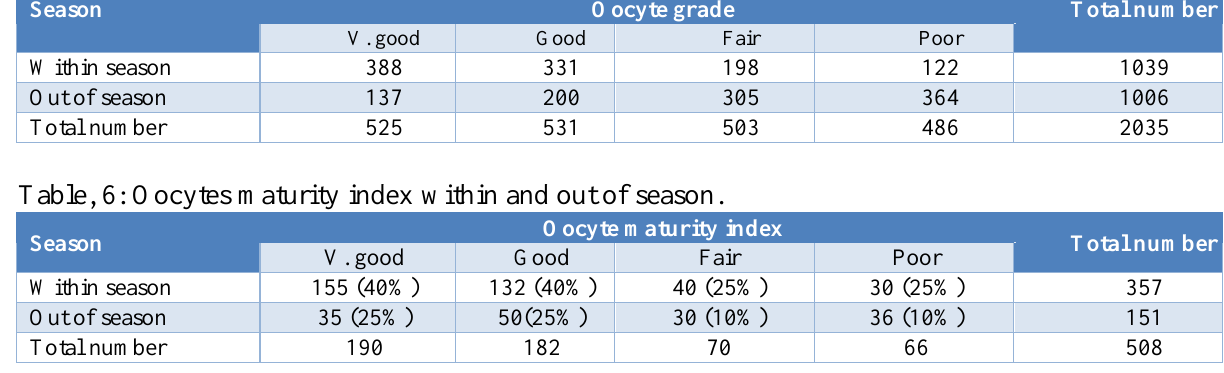
Table, 7: Embryo development within and out of season.